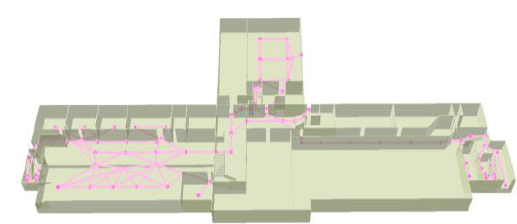
Figure 3. Library Patron Basement Network